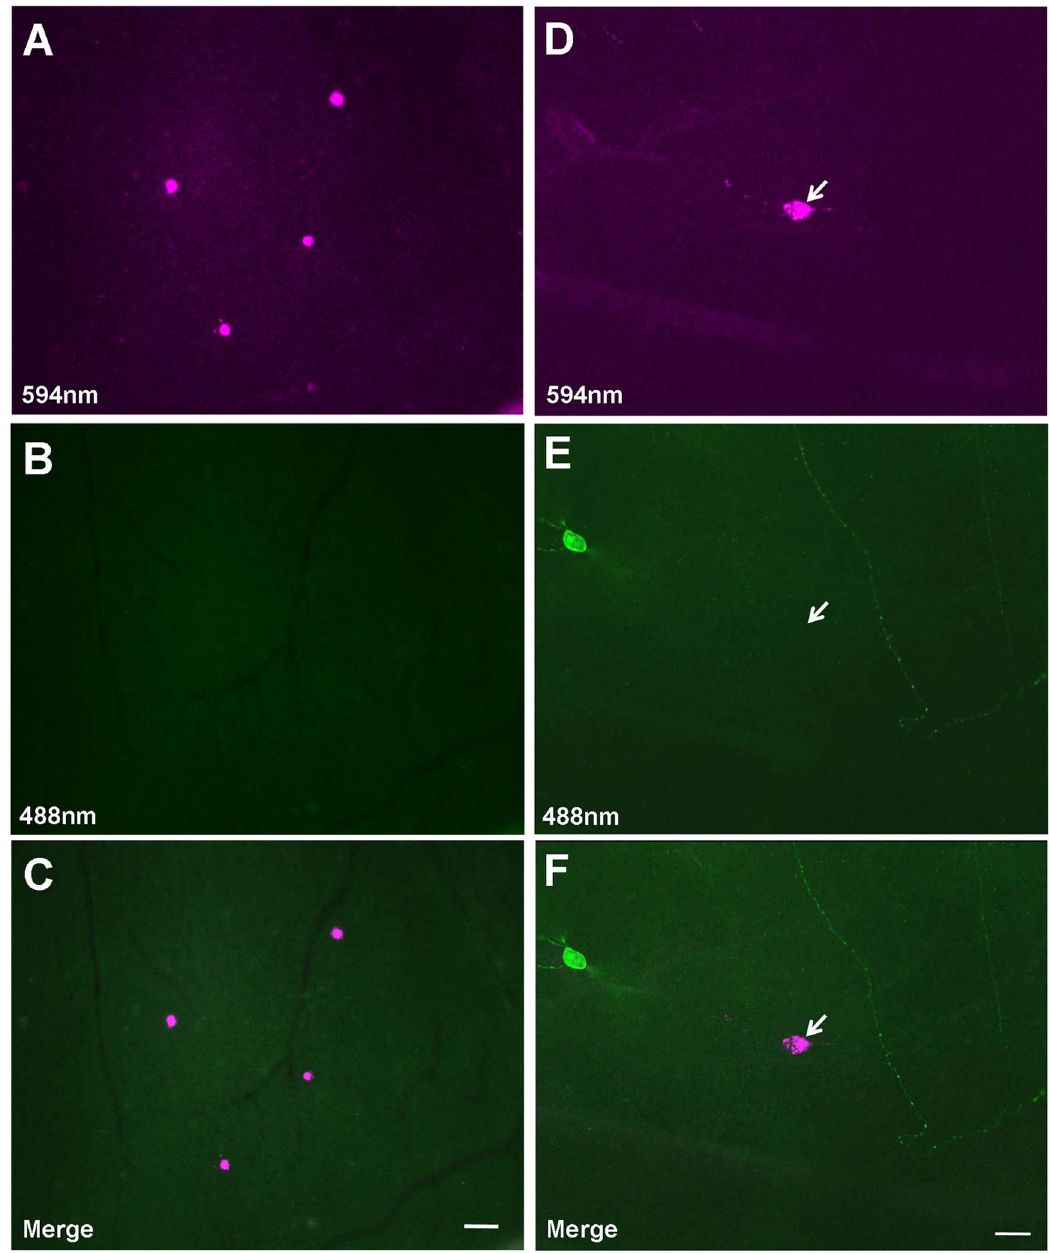
Figure 2. Illustration of Cholera toxin B subunit (CTB) retrogradely labeled-caudal periaqueductal gray (cPAG)-projecting retinal ganglion cells (RGCs). (A–C) Illustration of the CTB-conjugated Alexa Fluor 594 (CTB-594) retrogradely labeled RGCs in the retina. There are 4 CTB- labeled RGCs (magenta) in this field (A). These cells were not visible under blue excitation florescence filter (B). Merged photomicrograph of (A) and (B) is shown in (C). (D–F) A cPAG-projecting RGC is negative for anti-melanopsin staining. Arrow points to a CTB-594 retrogradely labeled cPAG- projecting RGC (D) that, as shown in (E), lacks melanopsin immunoreactivity. In contrast, melanopsin-positive RGCs were also seen. As shown in (E), the soma and dendrites of a melanopsin-expressing RGC (mRGC) were visible, so was an dendrite of another mRGC whose soma was not in the field (green fluorescent staining). Merged photomicrograph shows a cPAG-projecting RGC and a non-cPAG-projecting but melanopsin-positive RGC in the same field (F). Scale bars: 40 m m in C (applies to A and B); 20 m m in F (applies to D and E). (Pu, 1999). Contrast and brightness were adjusted and the red- green images had been converted to magenta-green.